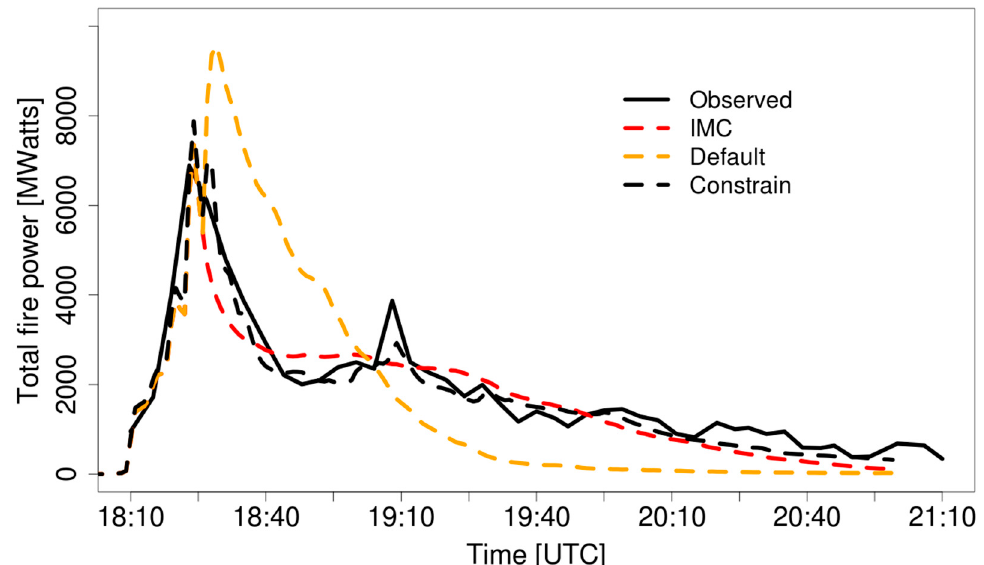
Figure 11. Observed vs. WRF-SFIRE modeled heat fluxes during the L2F prescribed burn.